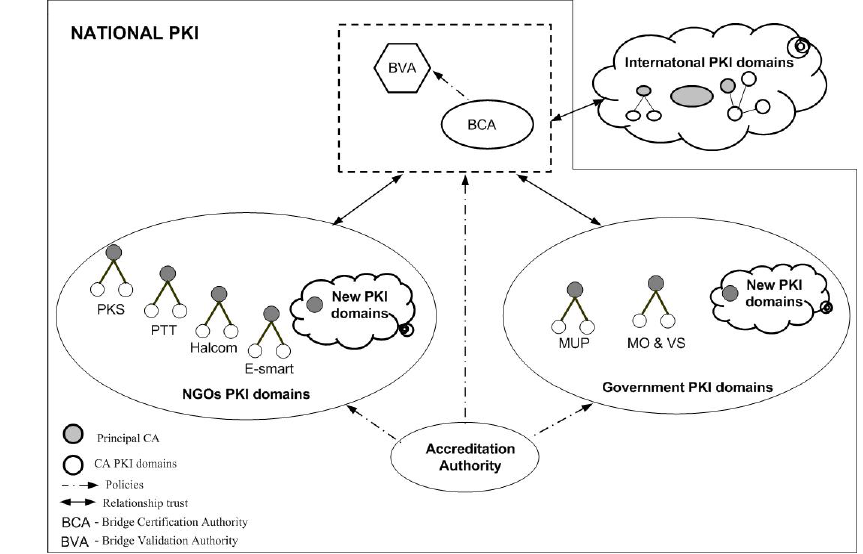
Figure 2 – The proposed model of PKI interoperabilty in the Republic of Serbia Рис . 2 – Предлагаемая модель ПКИ взаимодействия и доверия в Республике